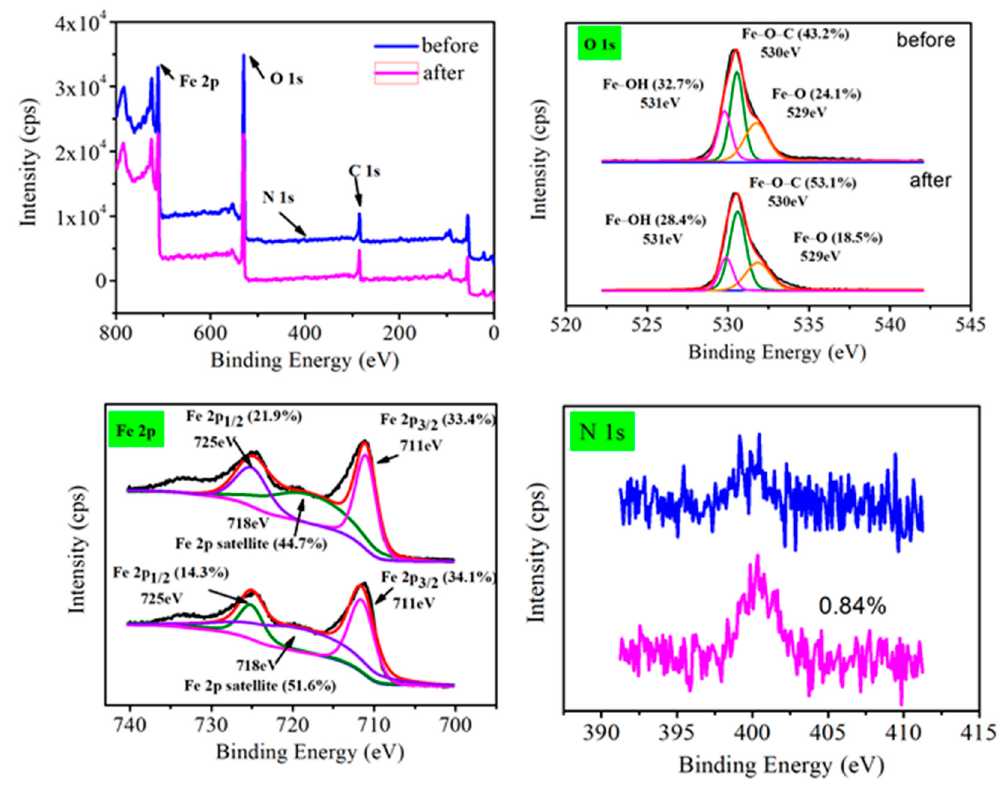
Figure 7. A full XPS spectra of Fe 3 O 4 @GO including O 1s, Fe 2p, and N 1s before and after the degradation of RhB.